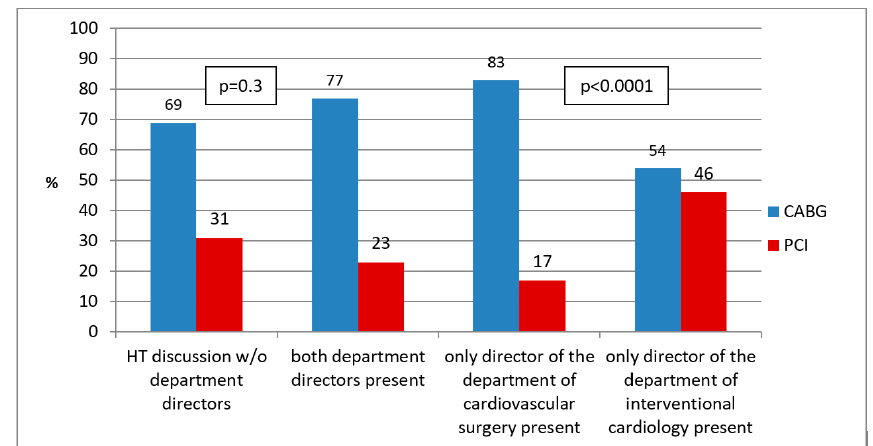
Figure 1. Heart Team decisions in relation to the absence or presence of the directors of the department of cardiovascular surgery or the department of interventional cardiology. Legend: Bar chart of patients either scheduled for CABG ( blue columns ) or PCI ( red columns ). HT = Heart Team; CABG = coronary artery bypass grafting; PCI = percutaneous coronary intervention; w/o = without.